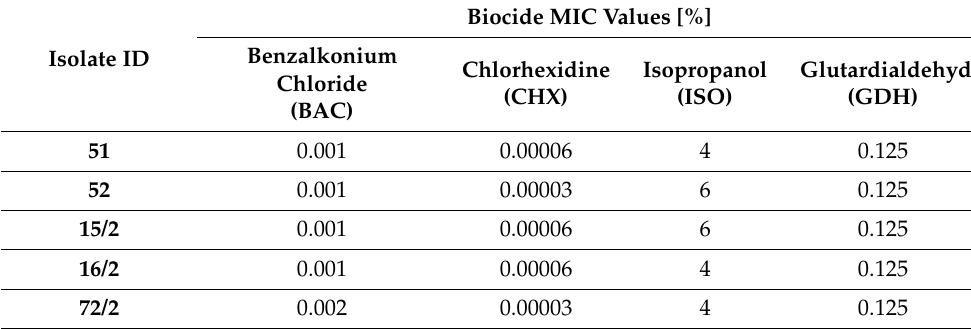
Table 3. Results of the biocide susceptibility testing of the five mcr -1-carrying E. coli